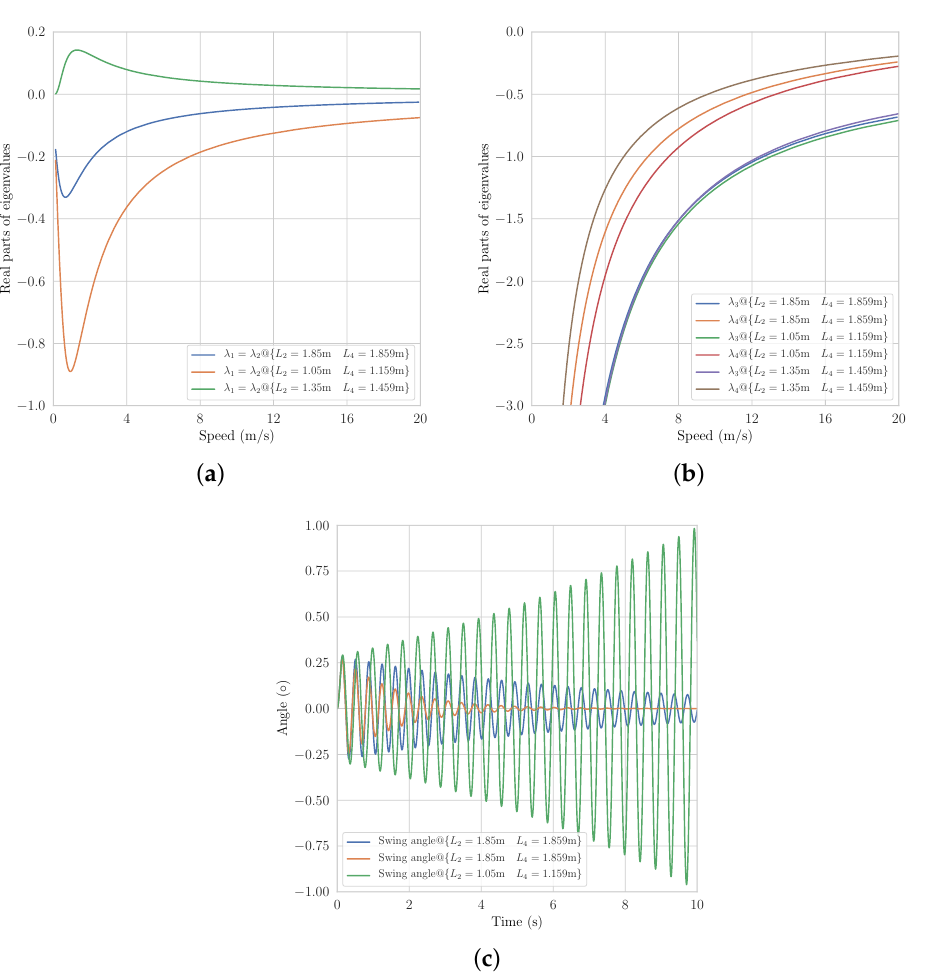
Figure 6. Variation of the real parts of the eigenvalues and swing angle with the center of mass: ( a ) real parts of λ 1 and λ 2 , ( b ) real parts of λ 3 and λ 4 , and ( c ) swing angle of the